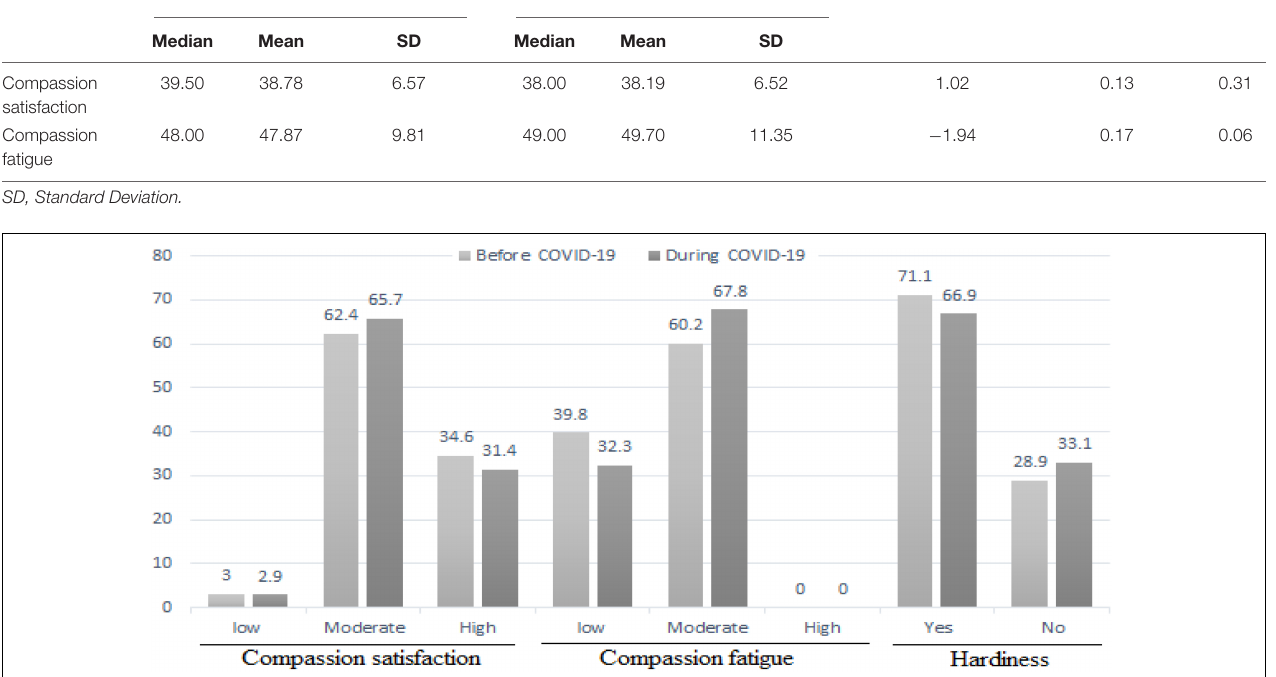
TABLE 2 | Comparison of the professional quality of life score among the participants before and during the COVID-19. Group Before COVID-19 ( n = 266) During COVID-19 ( n = 242) Variables